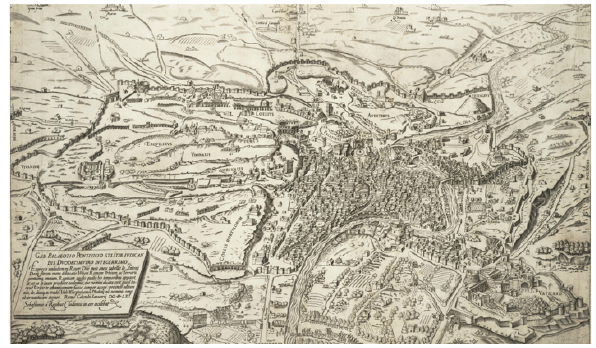
Figure 5. Map of Rome by Sebastiano di Dosio of 1561. Engraved in bronze by Sebastiano Re de Chioggia after Giovanni Antonio Dosio.